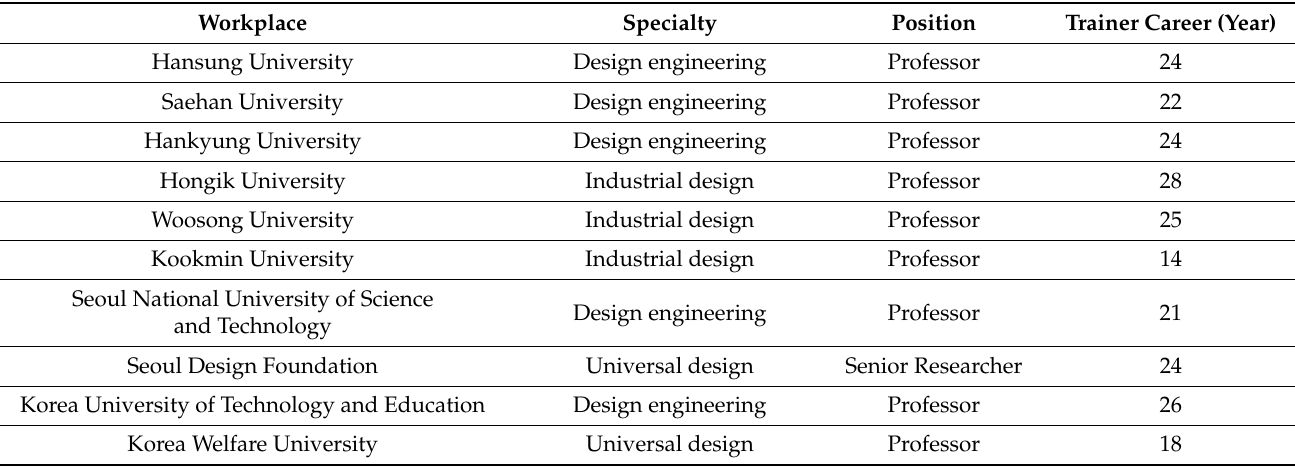
Table 2. Expert meeting